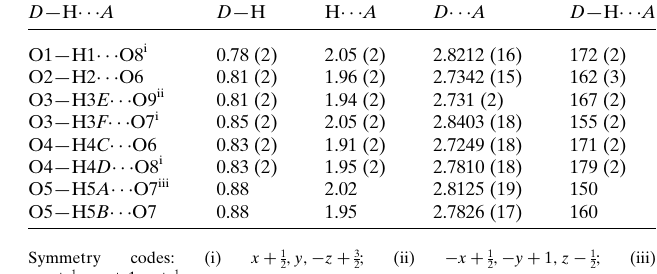
Table 1 Hydrogen-bond geometry (A˚ , (cid:3) ).